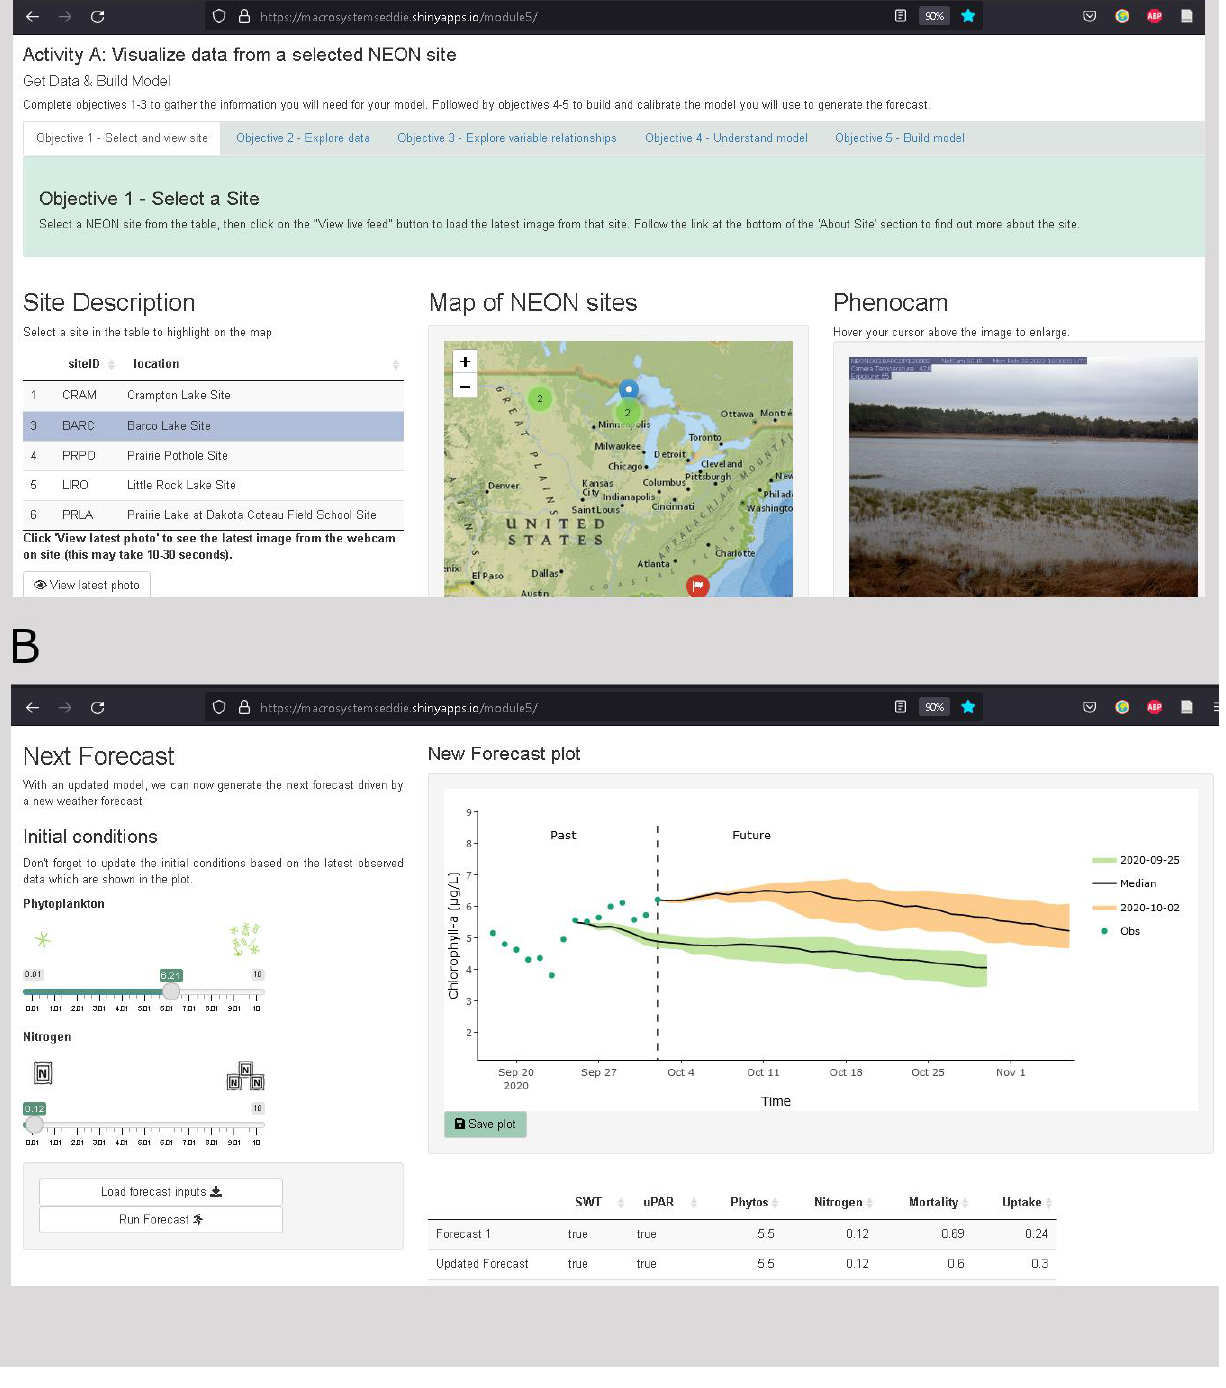
Figure 2. Screenshots from the R Shiny application that show example activities the students complete as part of the module and the tool’s high level of customization. ( A ) In Activity A, students select an aquatic site from the National Ecological Observatory Network (NEON) for which they will generate a productivity forecast. ( B ). In Activity B, students complete the near-term, iterative forecast cycle by updating their model parameters, with the aim of improving the next forecast. Each student within a pair builds their own model with inputs and parameters sep- arately, and then they compare the performance of two different models for the same lake ecosystem. Following completion of Activity A, the instructor brings the class together to discuss the model output as a group and asks the students questions regarding their